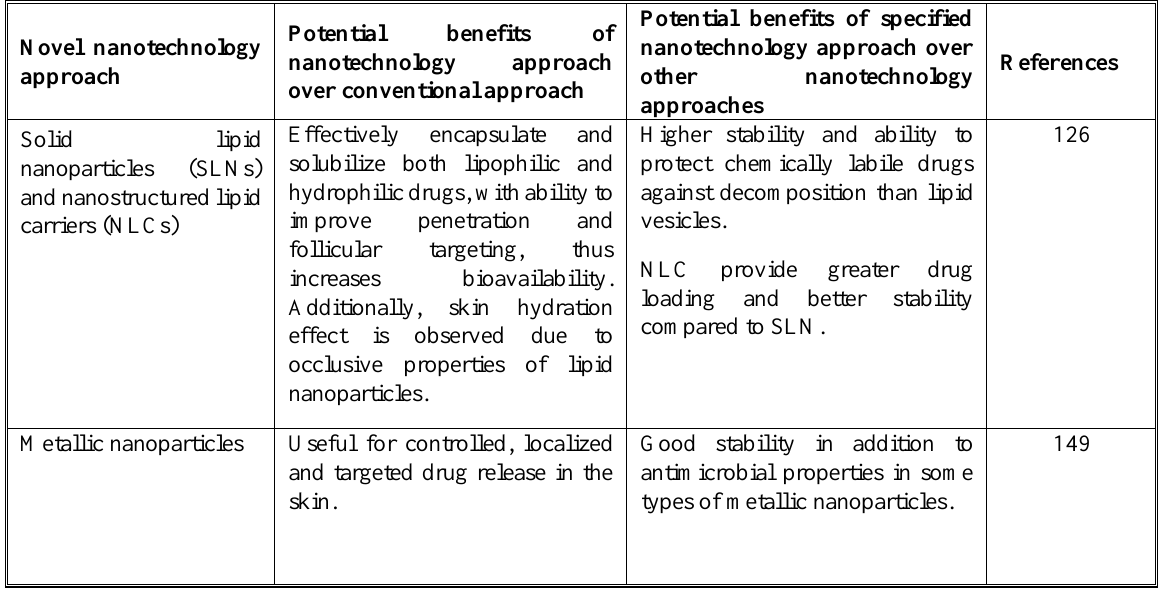
Continue Table 3.Potential benefits of novel nanotechnology approaches over the conventional dosage forms and potential advantages of nanotechnology approach compared to the other